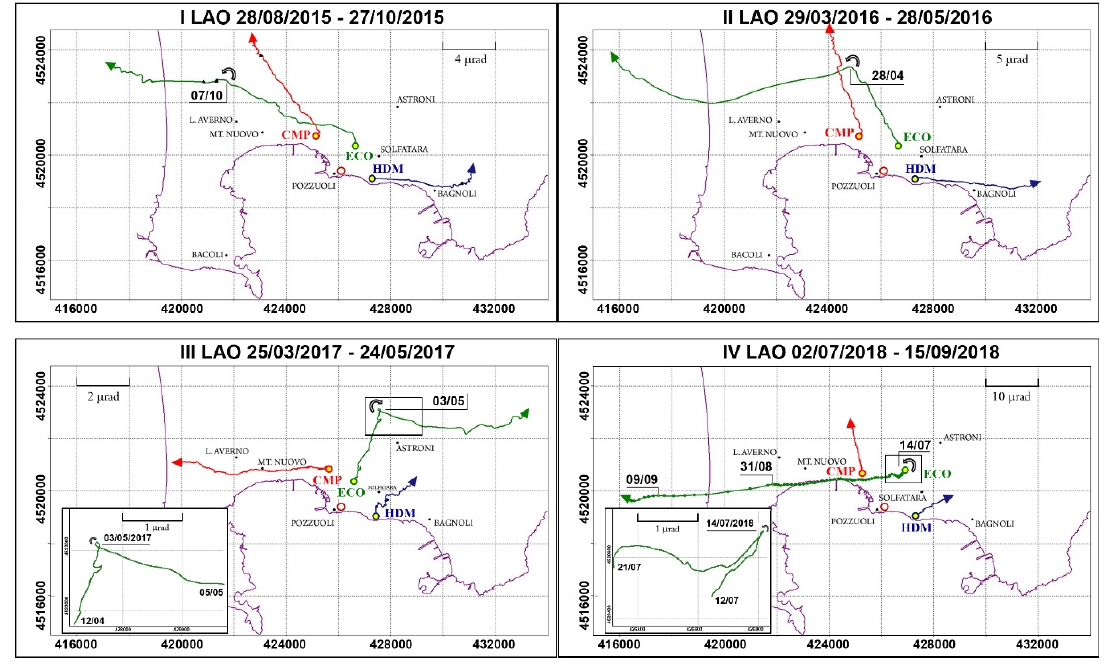
Figure 9. LAOs observed at ECO station in four different time spans discussed in the text. The tilt variations of 7 October 2015, 28 April 2016 (TR1), 3 May 2017 (TR2) and 14 July 2018 (TR3) are evidenced by a semicircular arrow pointing towards the reversal in tilting direction. The points superimposed to the ECO hodograph of the IV LAO mark the observed daily tilt, so the point spacing is proportional to the tilt rate. It can be observed how the tilt rate increases from 31 August 2018, stretching the soil towards the W until 9 September 2018, when the rate starts to decrease. The inset shows the zoom of the tilt reversals.